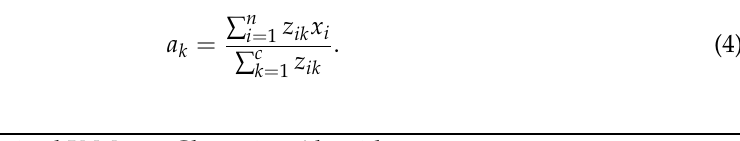
Algorithm 1 Unsupervised K-Means Clustering